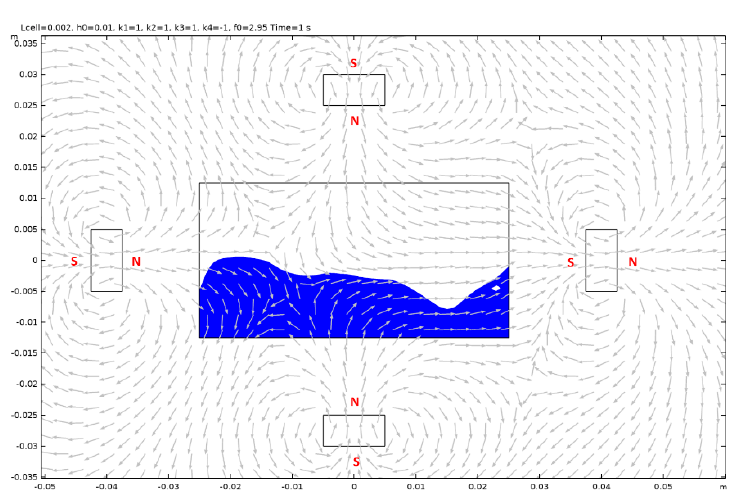
Figure A29. Case 15.